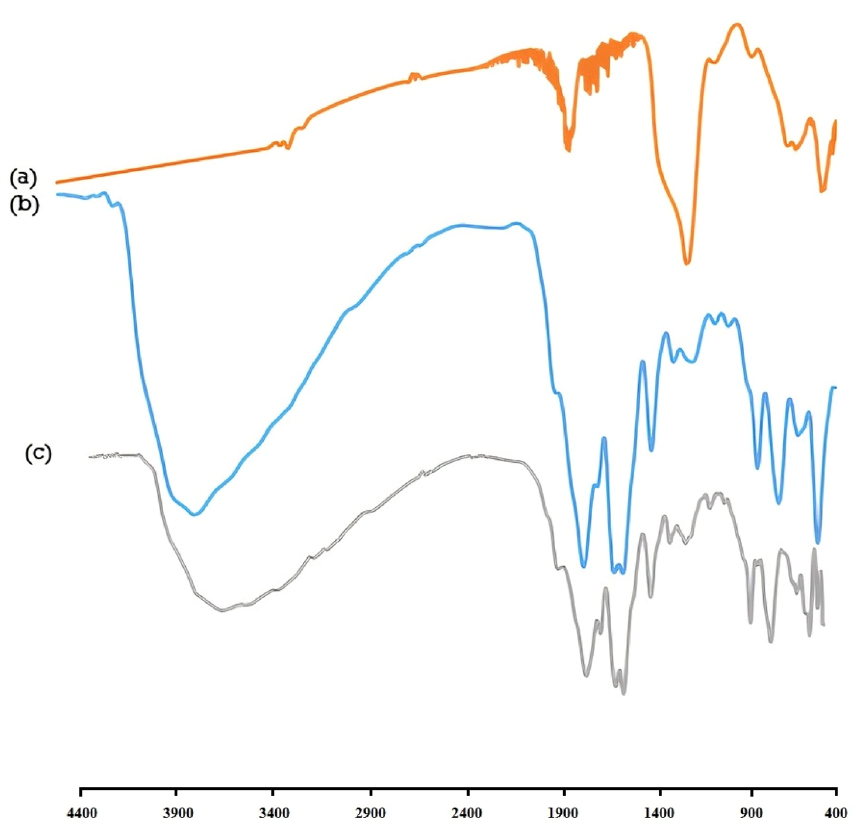
Figure 4. ( a – c ) The FTIR